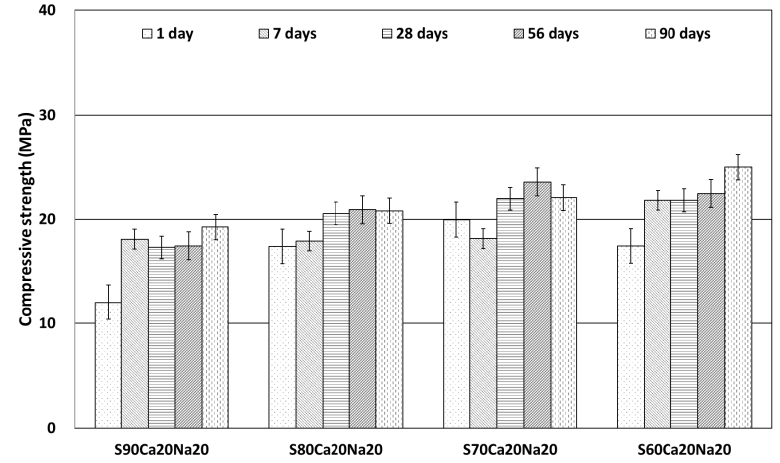
Figure 4. Compressive strength experiment results of high-purity air exposure